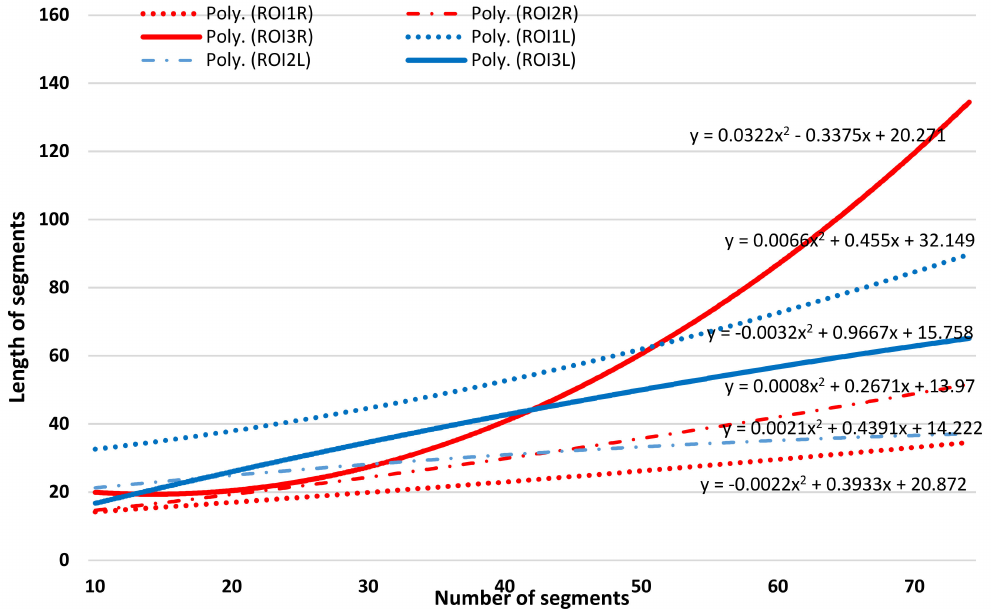
Figure 9. Fitted curves on number of skeleton segments vs. length of the segments (i.e., the corresponding connected pixels) for PD-weighted image for a patient with